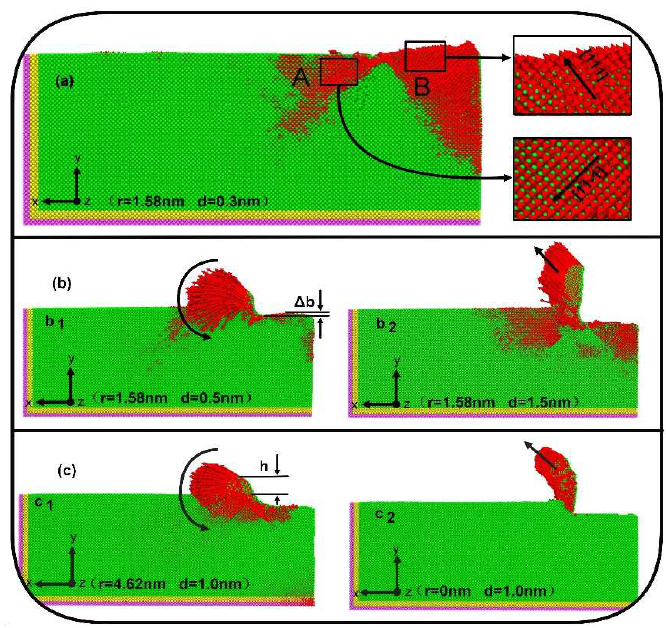
Figure 2. Atomic displacement vector of workpiece at different chip states. Here, Δb represents the elastic recovery distance, and h is the height of the strip chip (nm). The machining depths of ( a ) and ( b ) are 0.3 and 0.5 nm respectively, and the tool radius is 1.58 nm, ( c ) the machining depth is 1nm and the tool radius is 4.62 and 0 nm. The red arrow indicates the displacement vector.